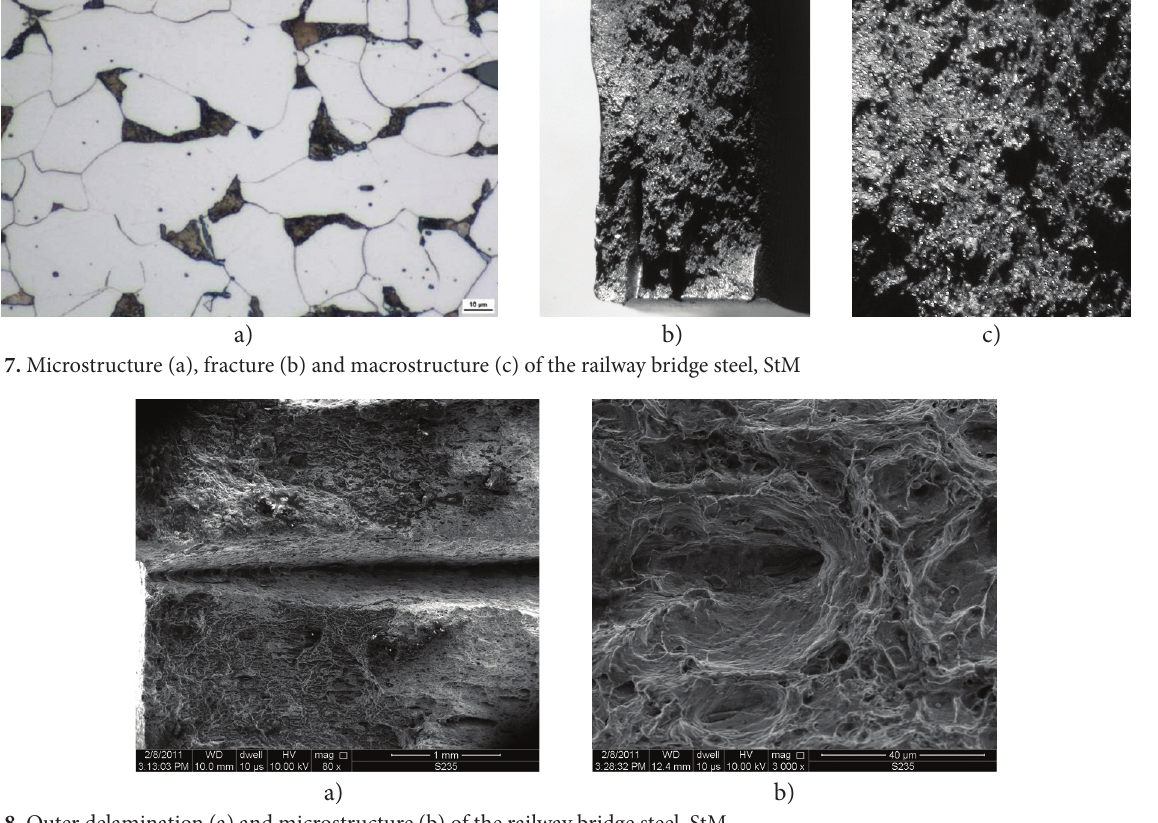
Fig. 8. Outer delamination (a) and microstructure (b) of the railway bridge steel, StM